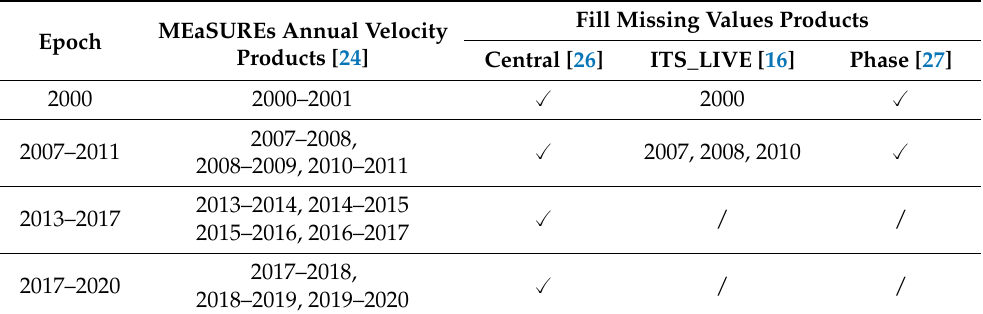
Table 1. List of the main ice velocity products and filling ice velocity products used in each of the epochs. MEaSUREs Annual Velocity Epoch Products